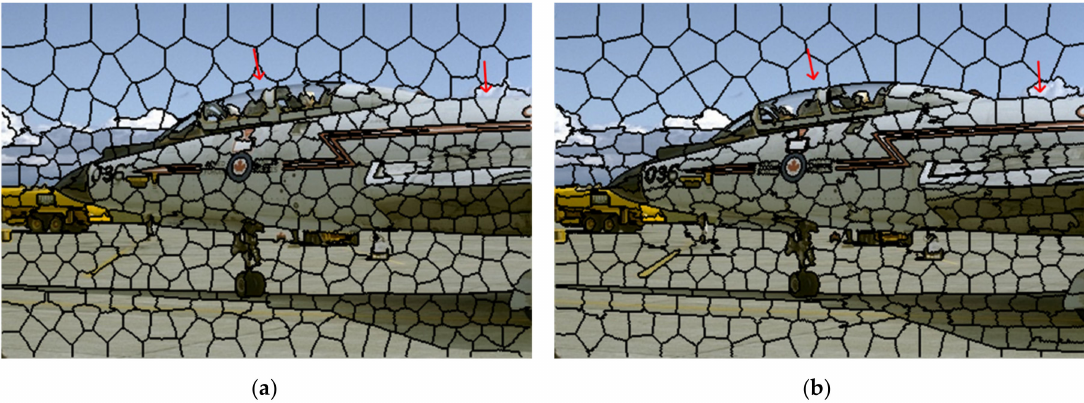
Figure 2. Image segmentation results with 400 superpixels. ( a ) Superpixel segmentation results after minimum spanning tree clustering, ( b ) superpixel segmentation results after boundary